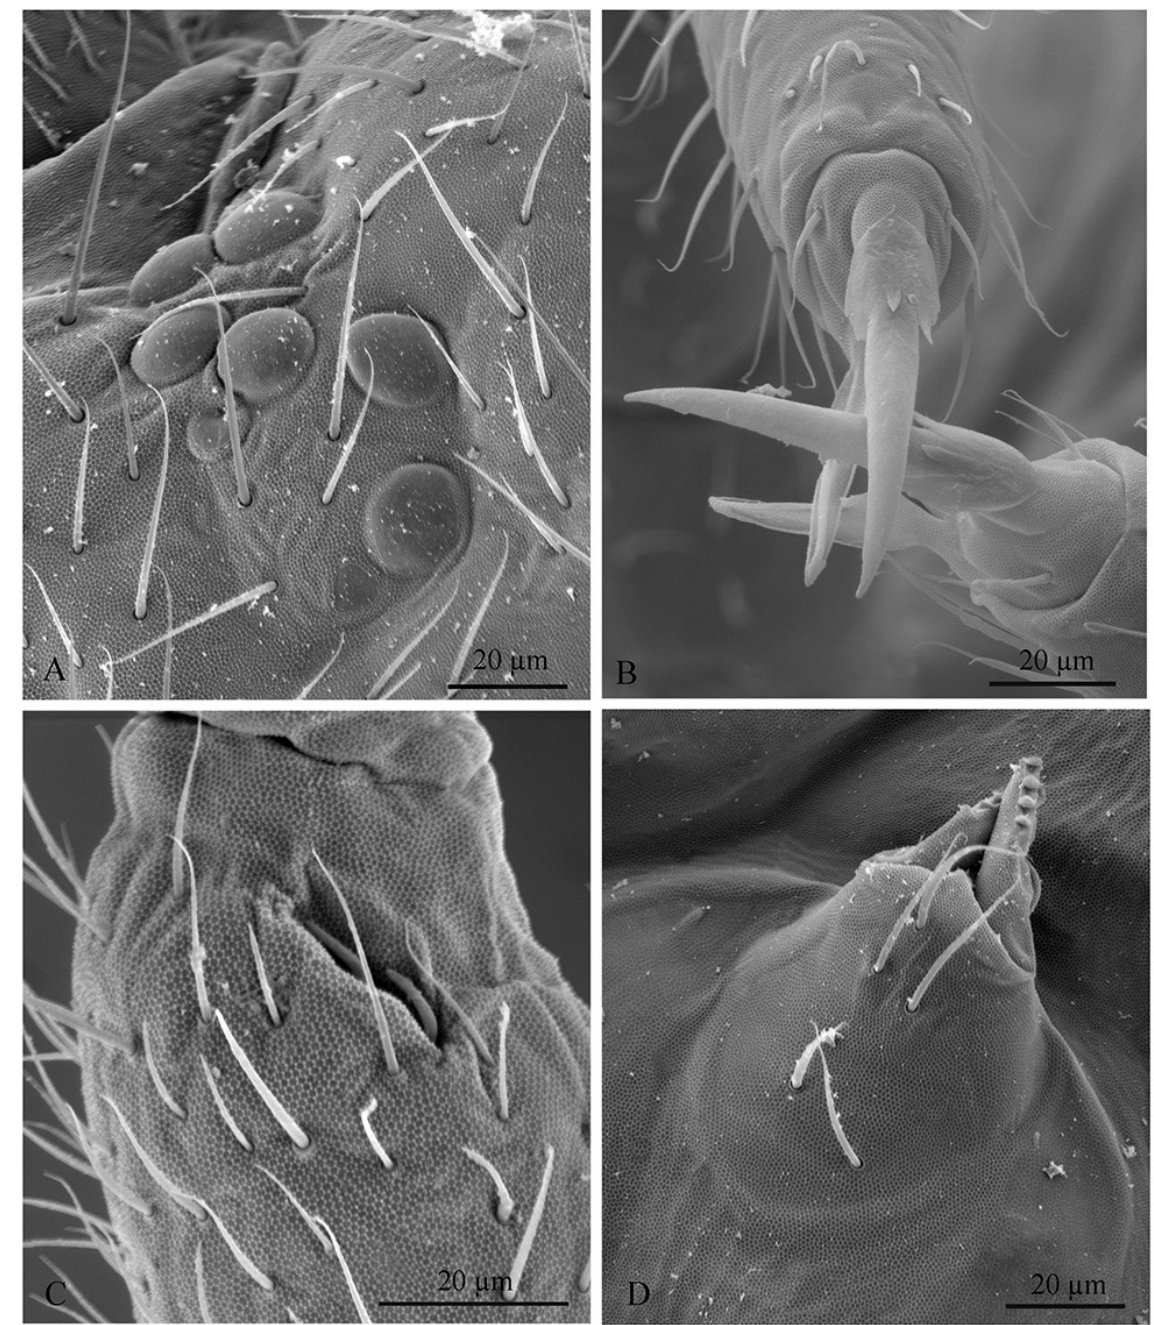
Fig. 5. Desoria calderonis sp. nov ., scanning electron microscopy. A . Ocular plate. B . Claws. C . Antennal organ III. D .